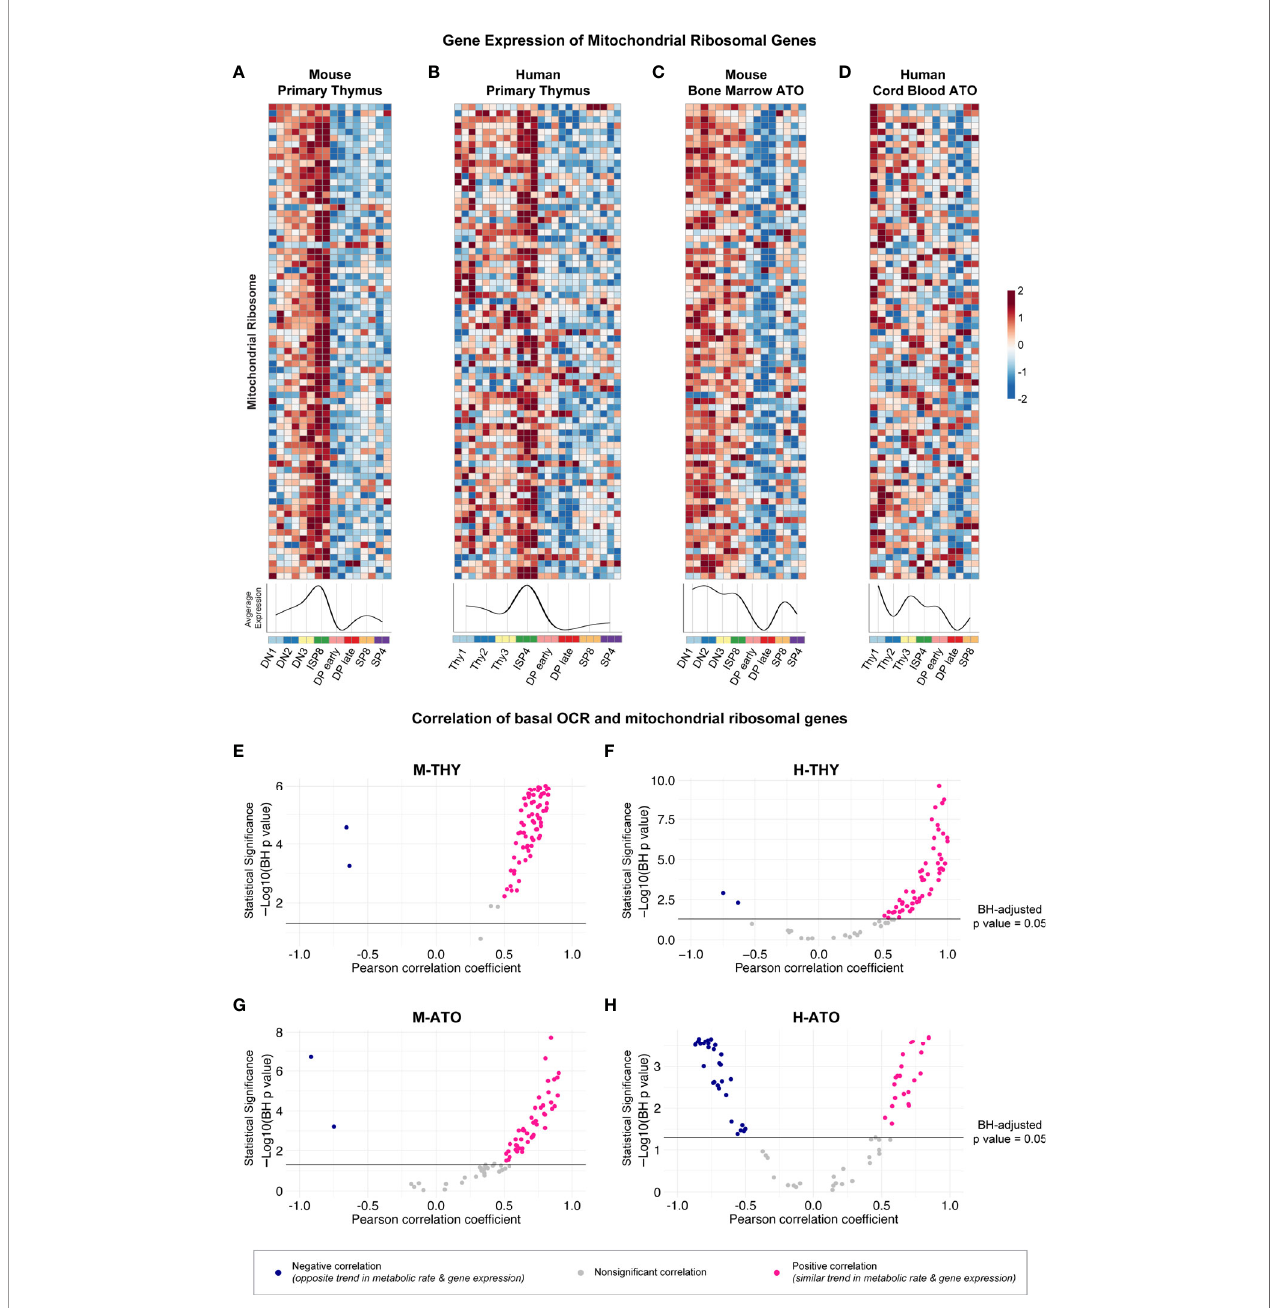
FIGURE 6 | (A-D) Heatmaps and summary line plots of mitochondrial ribosomal genes in (A) M-THY, (B) H-THY, (C) M-ATO, and (D) H-ATO. The x axis represents cells sorted from progenitor (DN1 or Thy1) to mature single-positive (SP) T cells. Each individual heatmap represents z -scores of normalized variance-stabilized gene expression data. Line plots represent the average z -score for all genes in the heatmap. (n=2 independent replicates per population in M-THY; n=3 in H-THY; n=2 in M-ATO; n=2 in H-ATO). (E – H) Scatter plots show correlation between mitochondrial ribosomal genes and basal respiration (OCR) in (E) M-THY, (F) H-THY, (G) M- ATO, and (H) H-ATO. The x axis represents the Pearson correlation coef fi cient R values calculated for individual genes within the speci fi ed metabolic pathway for all thymocyte populations for which respective extracellular fl ux data was collected. The y axis represents the statistical signi fi cance of each R value using -log10 of Benjamini-Hochberg adjusted p-values. Solid black line indicates an adjusted p-value of 0.05; all R values above the line are statistically signi fi cant. Genes with R values >0.5 (pink) are positively correlated with metabolic fl ux data, while genes with R values <-0.5 (blue) are negatively correlated with metabolic fl ux data. Nonsigni fi cant or weak correlation R values >-.05 or <0.5 are indicated in grey. (M-THY: n=6 fl ux analysis values for 5 populations, n=2 RNA-seq replicates; H-THY: n=3 fl ux analysis values for 5 populations, n=3 RNA-seq replicates; M-ATO: n=6 fl ux analysis values for 3 populations, n=2 RNA-seq replicates; H-ATO: n=6 fl ux analysis values for 3 populations, n=2 RNA-seq